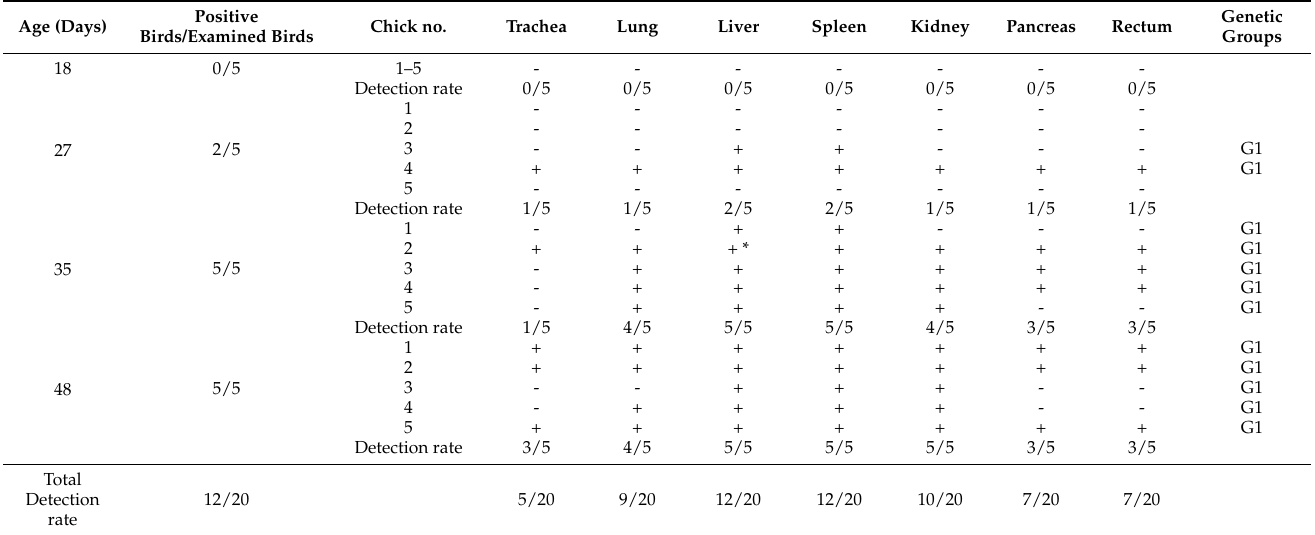
Table 1. Detection of GyVg1 in various organs in chicken from farm M.